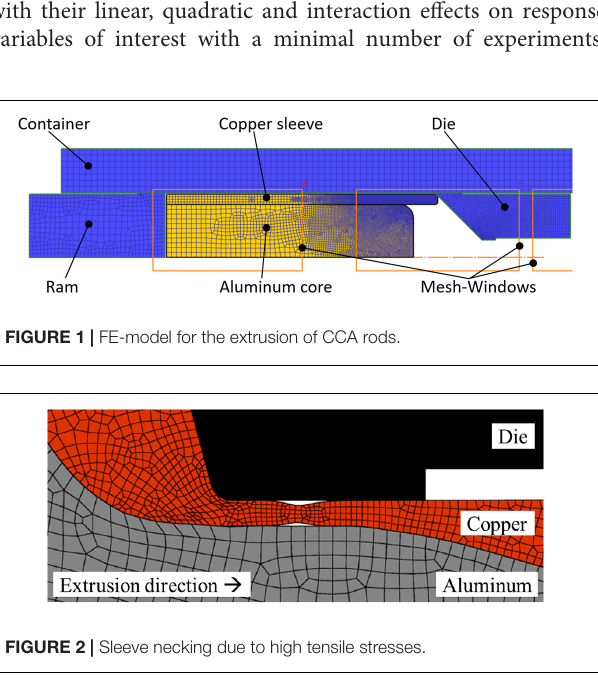
Regression coefficients